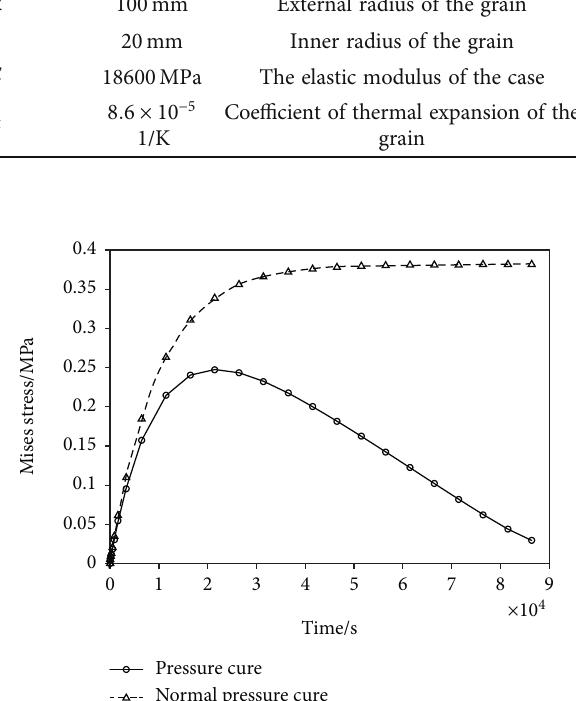
Figure 4: Mises stress time history